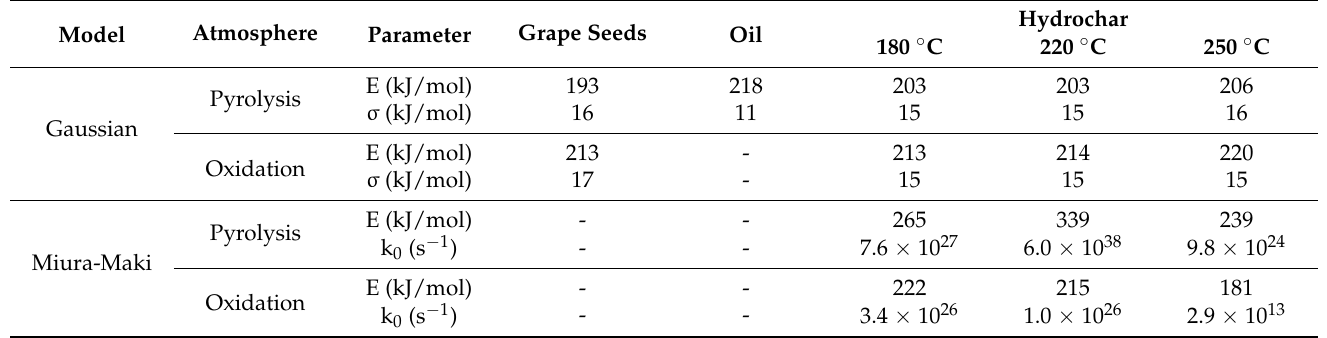
Table 6. Average values of E, σ , and k 0 computed through the Gaussian and Miura–Maki models (k 0 constant and equal to 1.67 × 10 13 s − 1 for the Gaussian